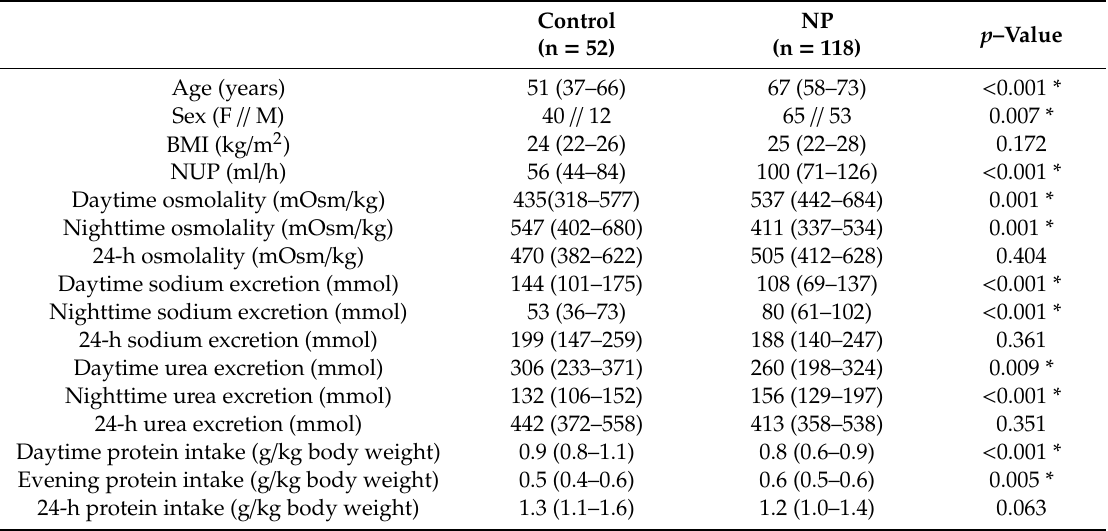
Table 1. Study population